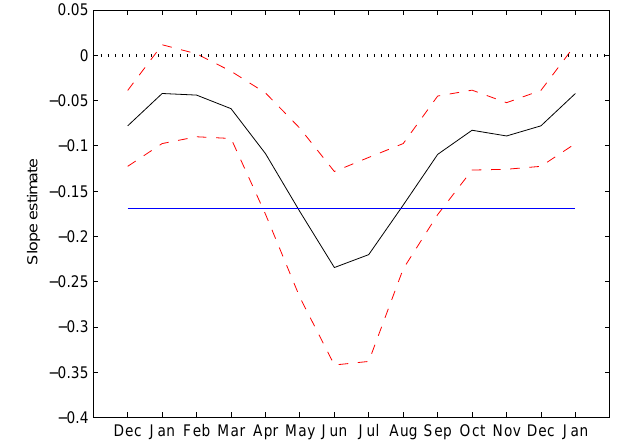
Figure 5. Time sequences from December, January, February, ..., November, December, January, showing WTS-estimated slope co- efficients with upper and lower limits from point-wise 95% boot- strap percentile confidence intervals, for the spatial standard devi- ation vs. spatial mean of the original data { z ( s ,t ) } . The horizon- tal solid blue line is the WTS-estimated slope coefficient for all- months-combined, and the horizontal dotted black line is the zero